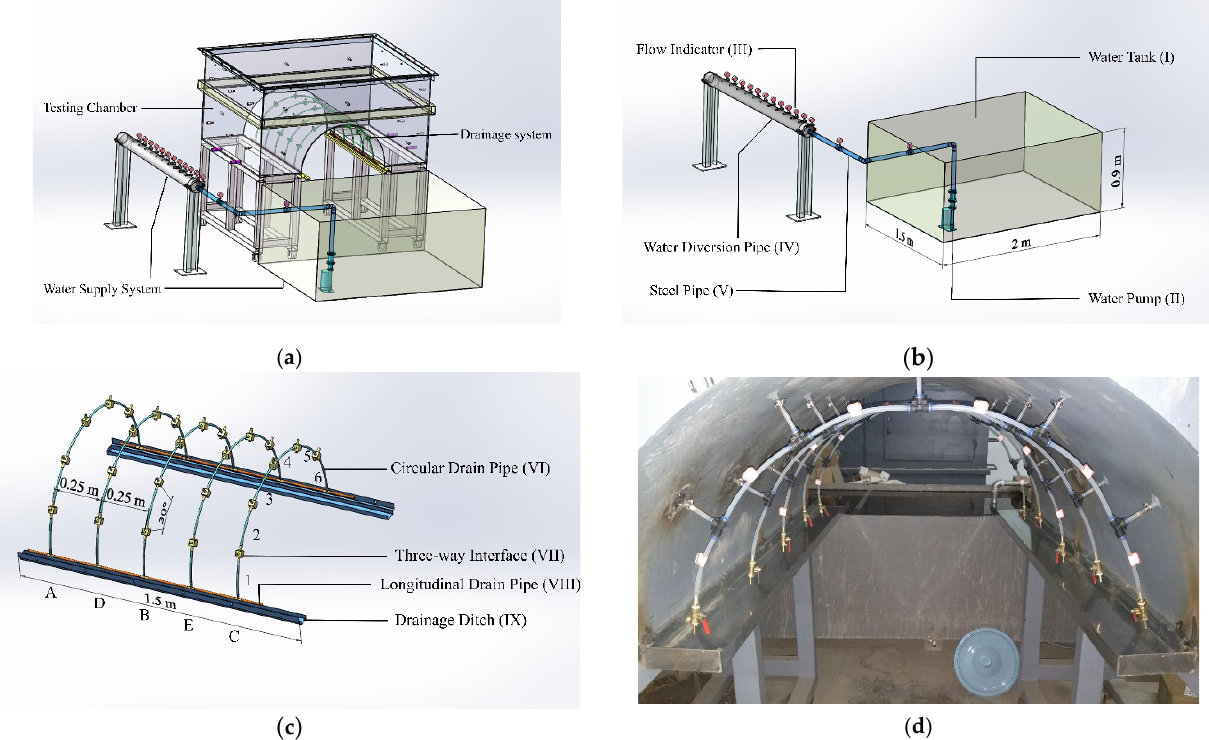
Figure 1. Sketch of experimental equipment for drainage system. ( a ) The overall equipment. ( b ) Schematic diagram of water supply system. ( c ) Schematic diagram of the drainage pipes. ( d ) Physical equipment of the drainage pipes.